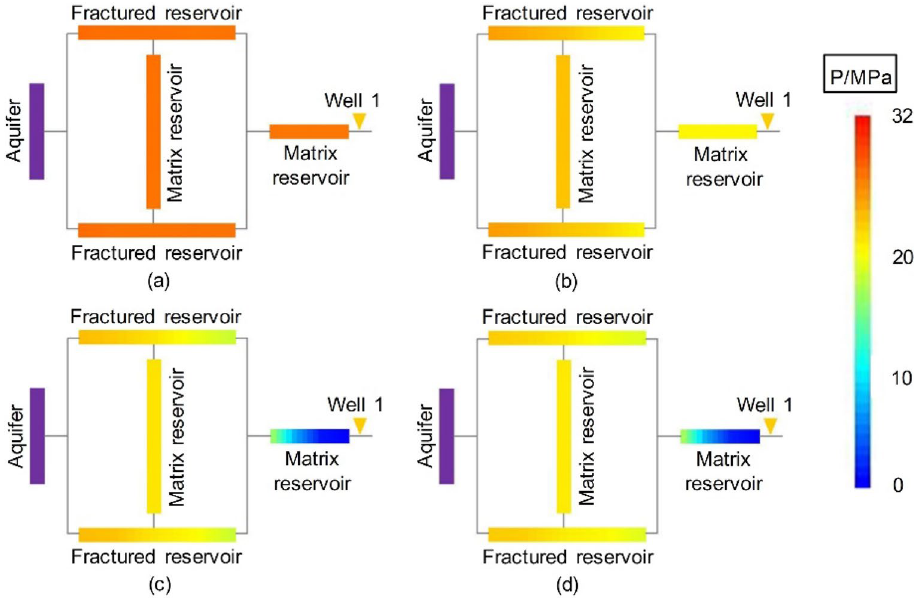
Figure 9. Pressure distributions at different stages of Experiment 1-2: ( a ) early stage of production—10 min, ( b ) early stage of production—20 min, ( c ) end of the stabilized period—30 min, and ( d ) production halts—49 min.